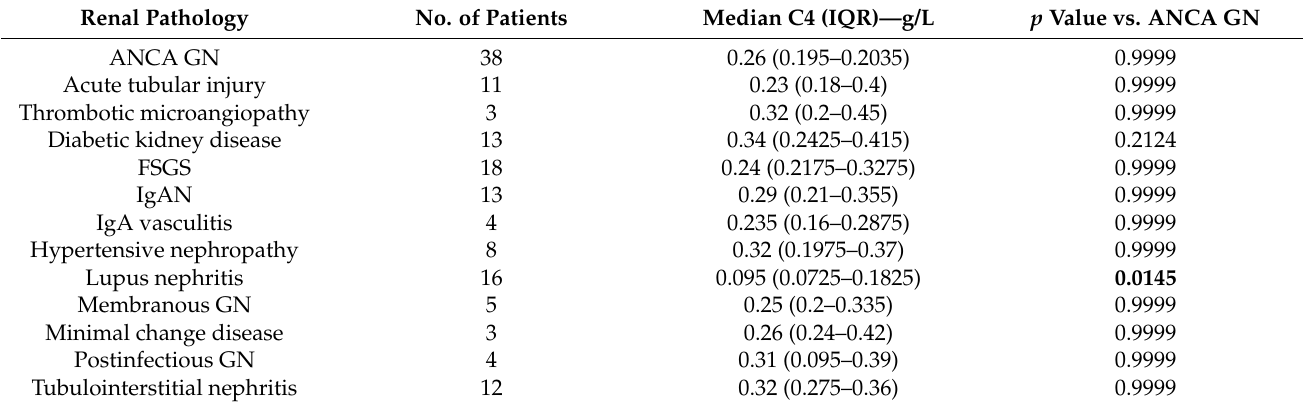
Table 5. Levels of circulating C4 among different renal pathologies (normal range: 0.15–0.57